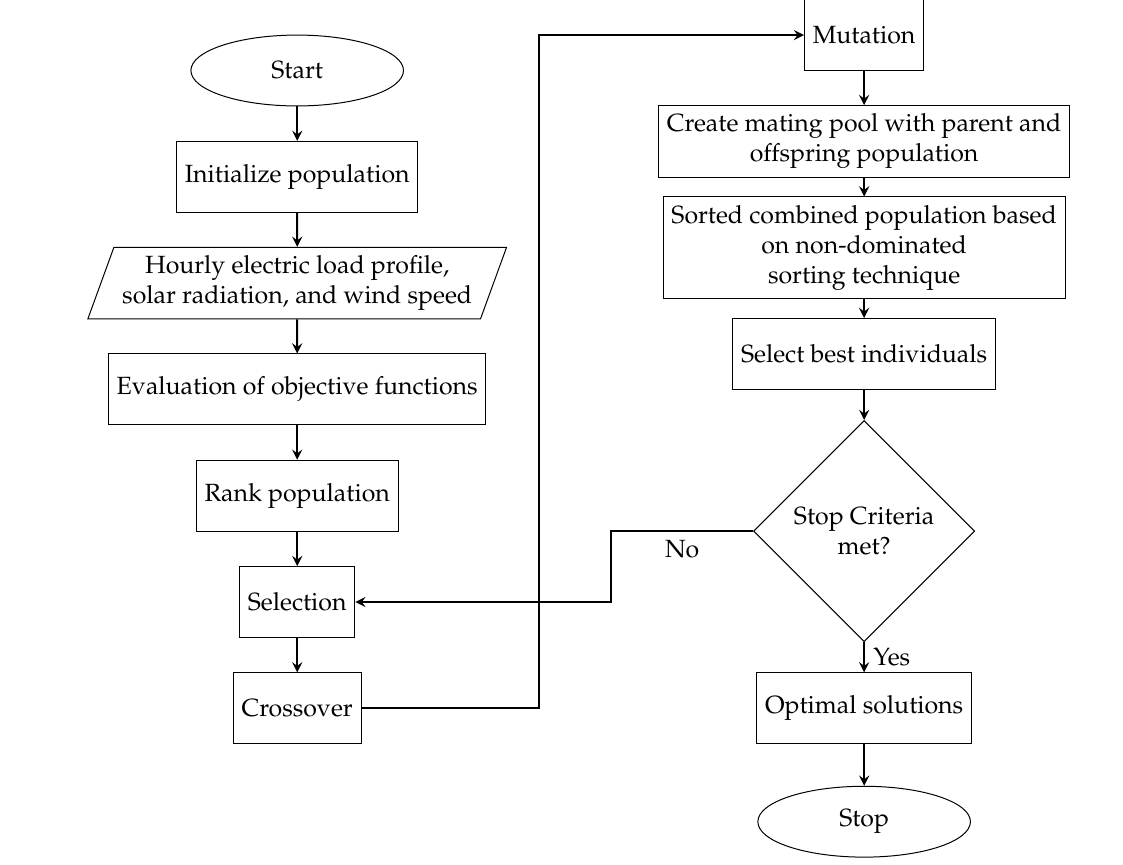
Figure 6. Flow chart of NSGA-II optimization technique.